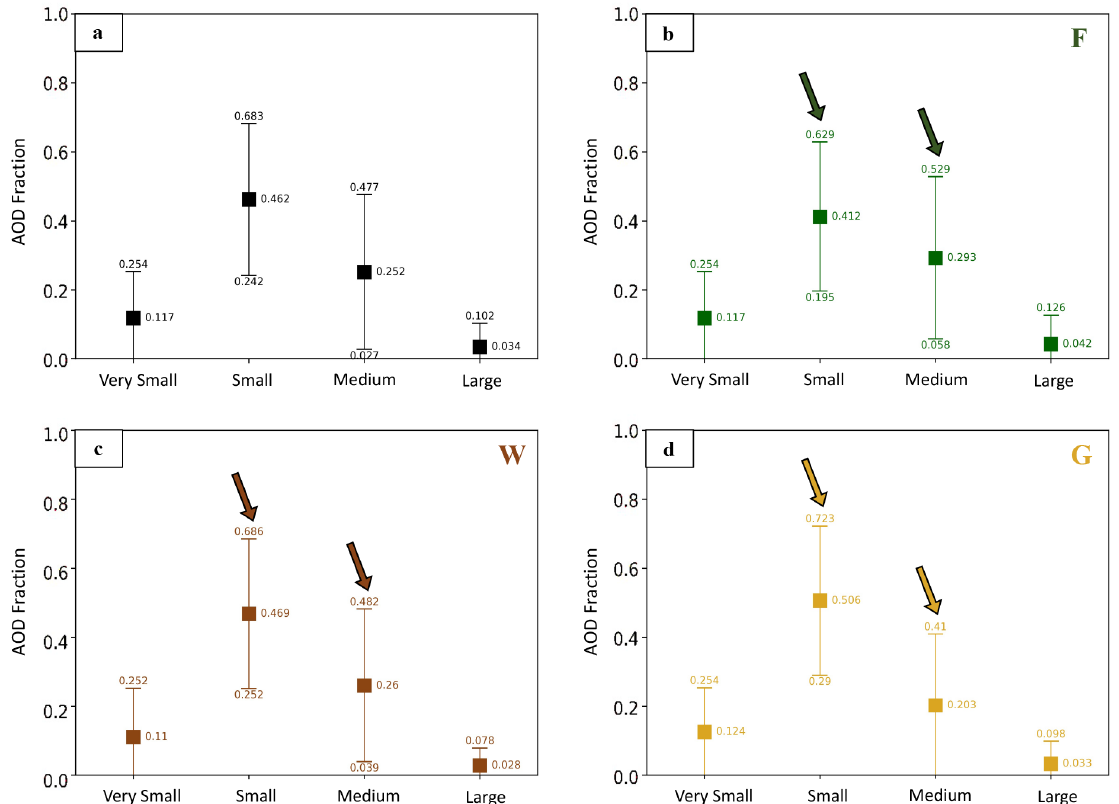
Figure 3. Particle size distributions in terms of each RA component’s fractional contribution to the total AOD. All plume types are shown in panel (a) , whereas panels (b) – (d) display color-coded results for individual plume types, denoted with the appropriate abbreviation in the upper right-hand corner. Points represent the mean values, and whiskers show the standard deviations. Arrows highlight the differences in the partitioning between the small and medium particle fractions for the different plume